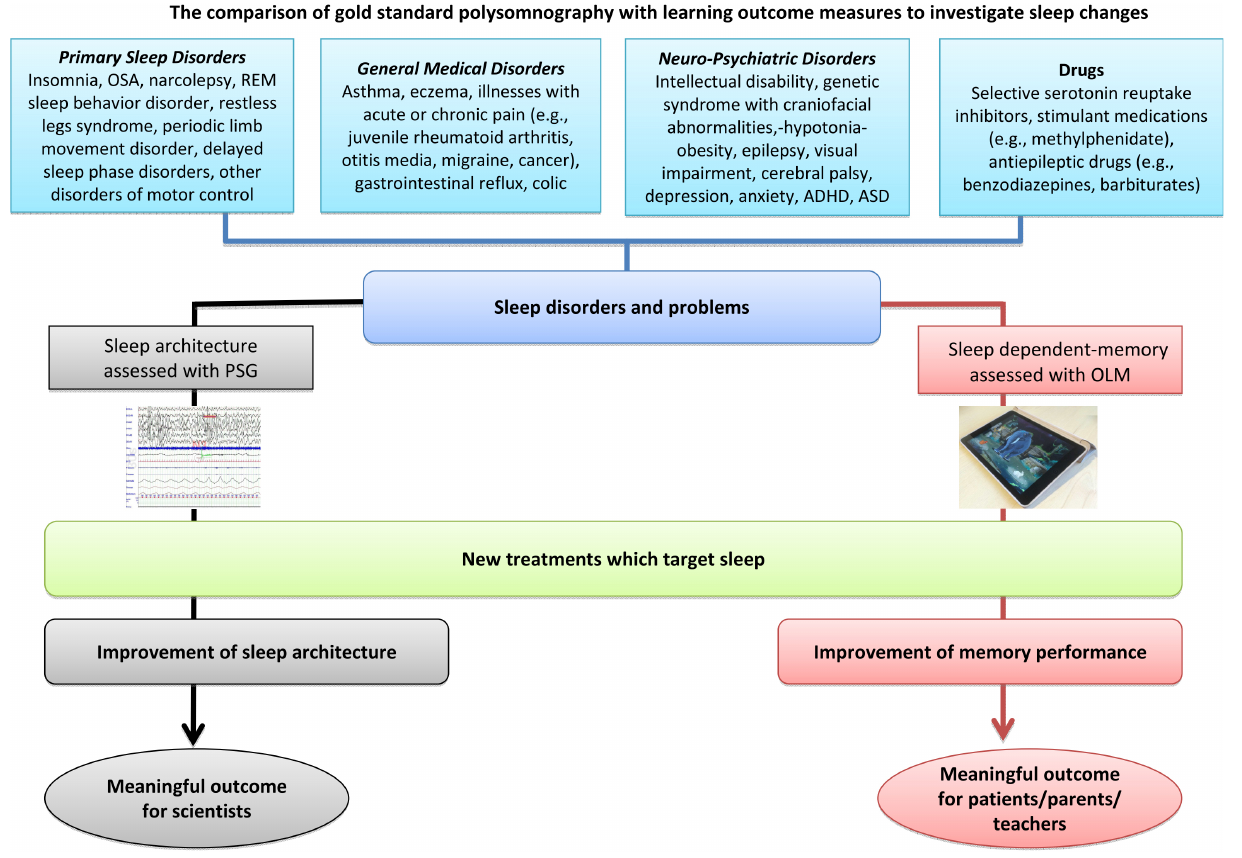
a 2D map is provided briefly for a 3D maze learning task. Performance is evaluated through number of decision points passed; total decision time; and navigation speed (number of decision points/total decision time). (C) Language learning: a set of animals is presented together with their names in an unfamiliar language. After a 12 min duration the unfamiliar animal names have to be recalled. Performance is evaluated through number of animals correctly recalled.